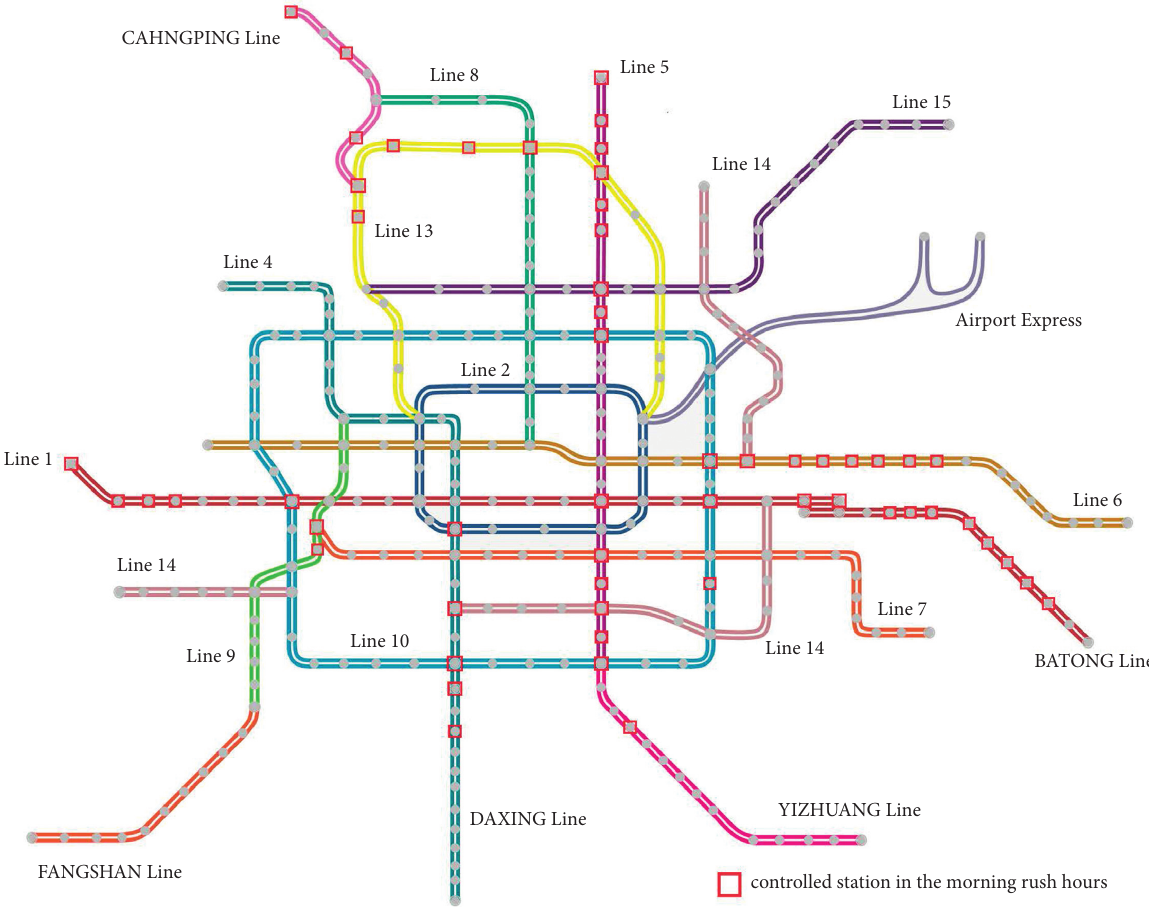
Figure 4: Beijing urban rail transit network (May